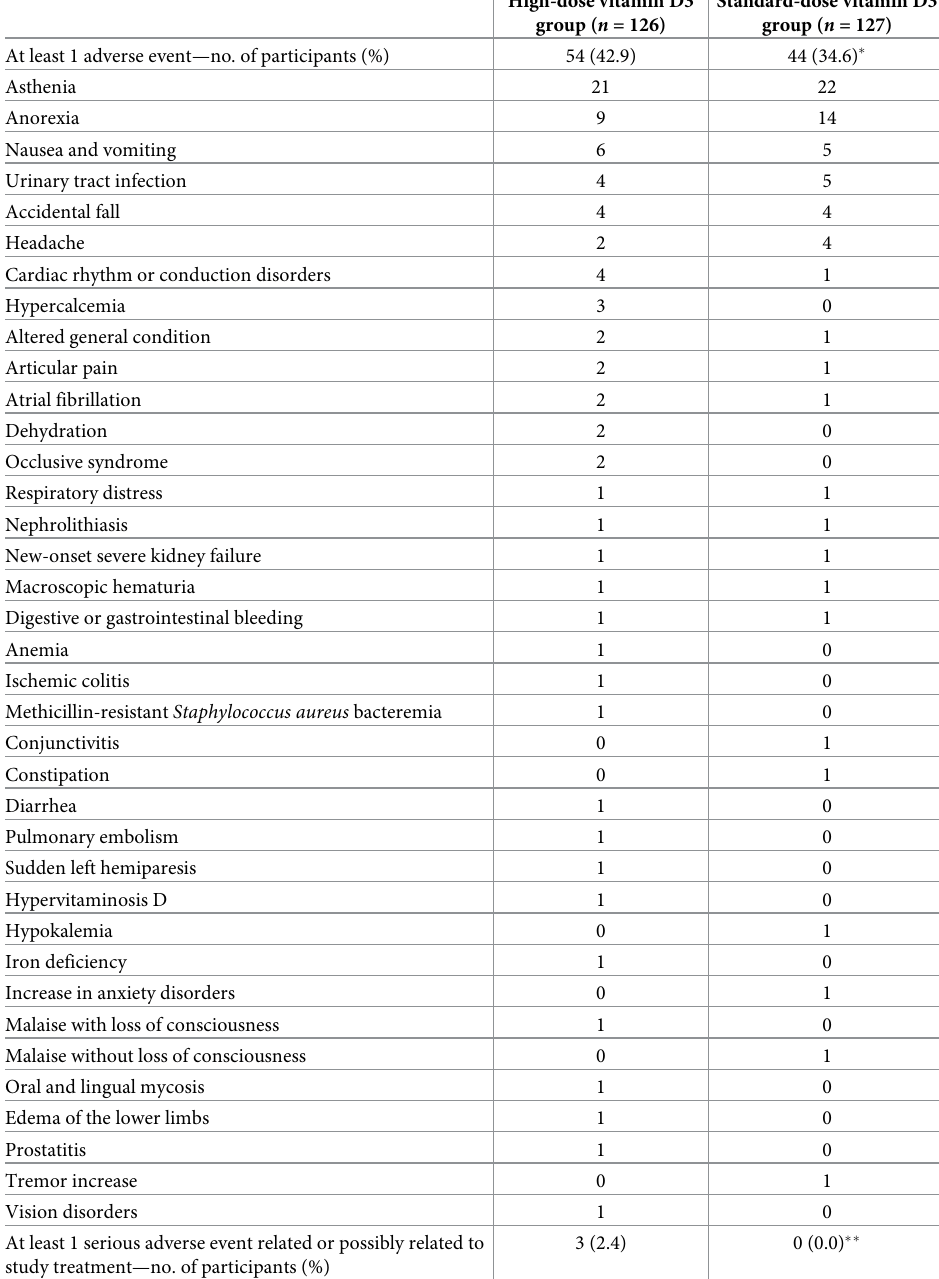
Table 3. Protocol-specified adverse